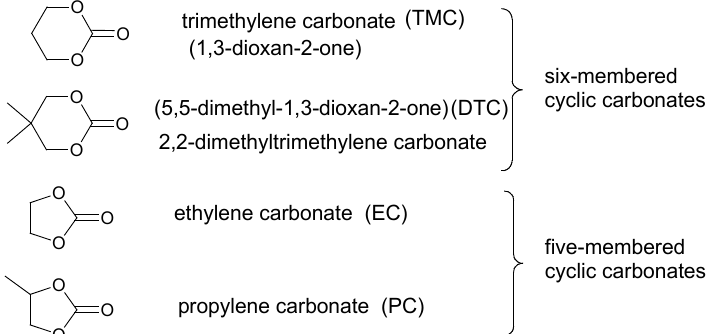
Figure 8. Structures of five‐ and six‐membered cyclic carbonates.